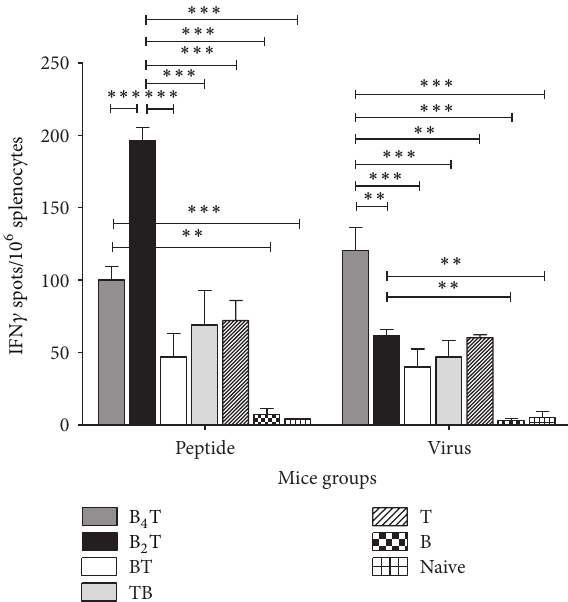
Figure 5: Frequency of peptide- and virus-specific IFN 𝛾 -producing cells in the spleen of immunized mice. IFN 𝛾 -producing cells were measured by ELISPOT assay in four animals from each group. Cells were stimulated with peptide (white bars) or FMDV (grey bars). Data are presented as the mean for four mice; error bars represent standard